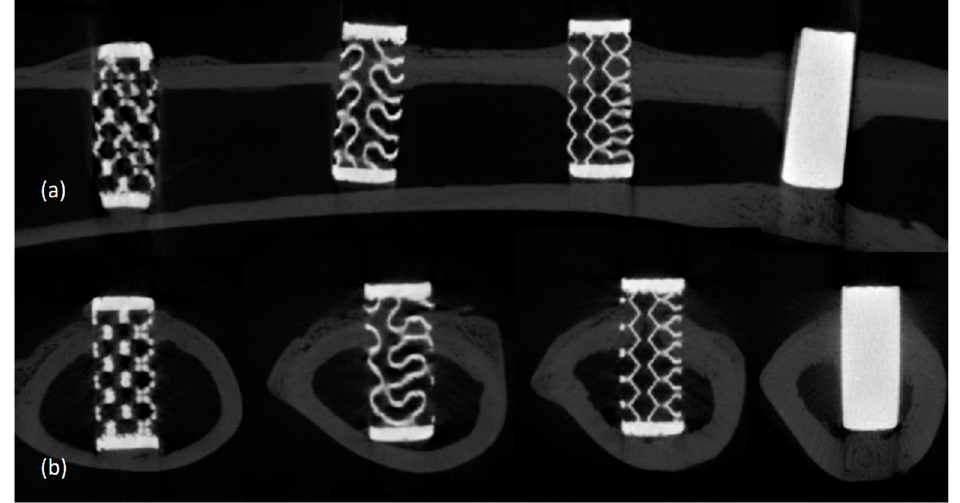
Figure 4. Micro-computed tomography findings of the titanium specimens with four different pore designs. ( a ) Longitudinal directional images (Dode, Gyroid, Octadens, and Solid (sham)). ( b ) Axial images (Dode, Gyroid, Octadens, and solid (sham)).